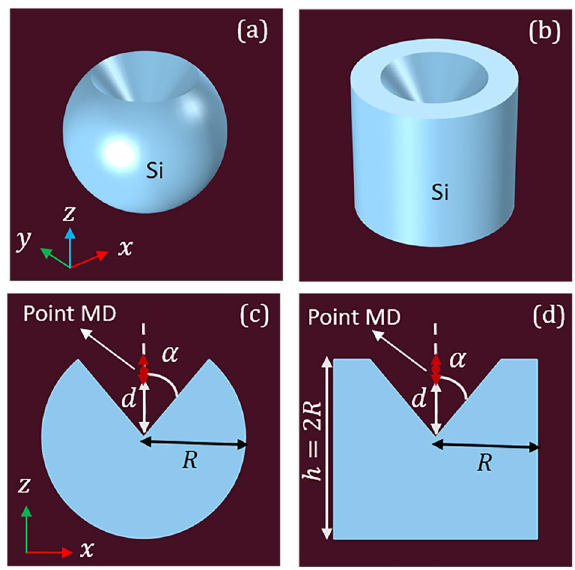
Figure 1. Illustration of ( a ) spherical and ( b ) cylindrical silicon resonators of radius R . The cylindrical body has 2 R . A conical well with angle α and centered apex is additionally drilled in the sphere and a heigh h =